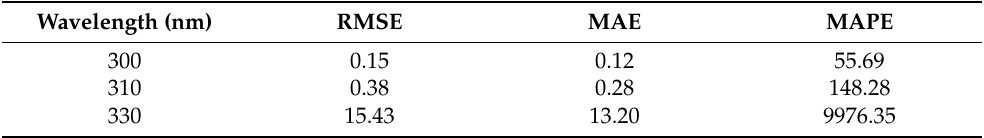
Figure 9. Single-wavelength inversion results at 330 nm. The errors in SO 2 concentration inversion using UV images at the three wavelengths are shown in Table 2.